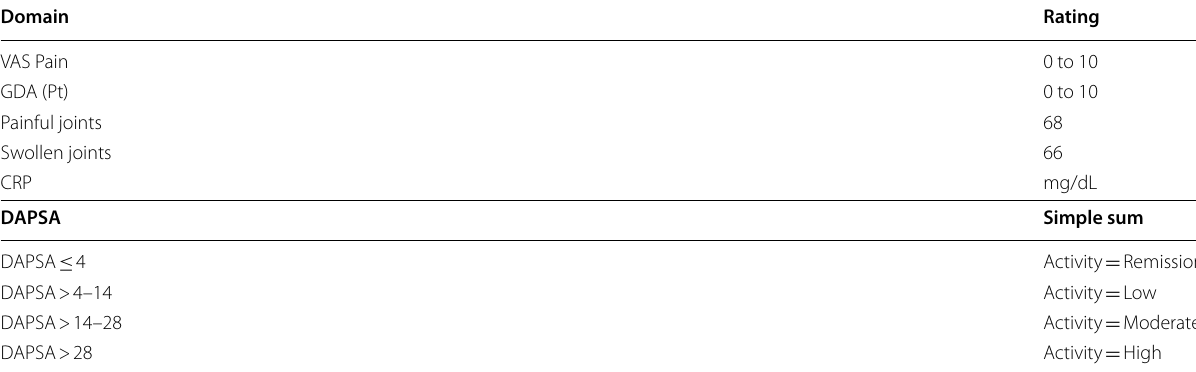
Table 1 DAPSA criteria for the evaluation of inflammatory disease activity [7, 197]